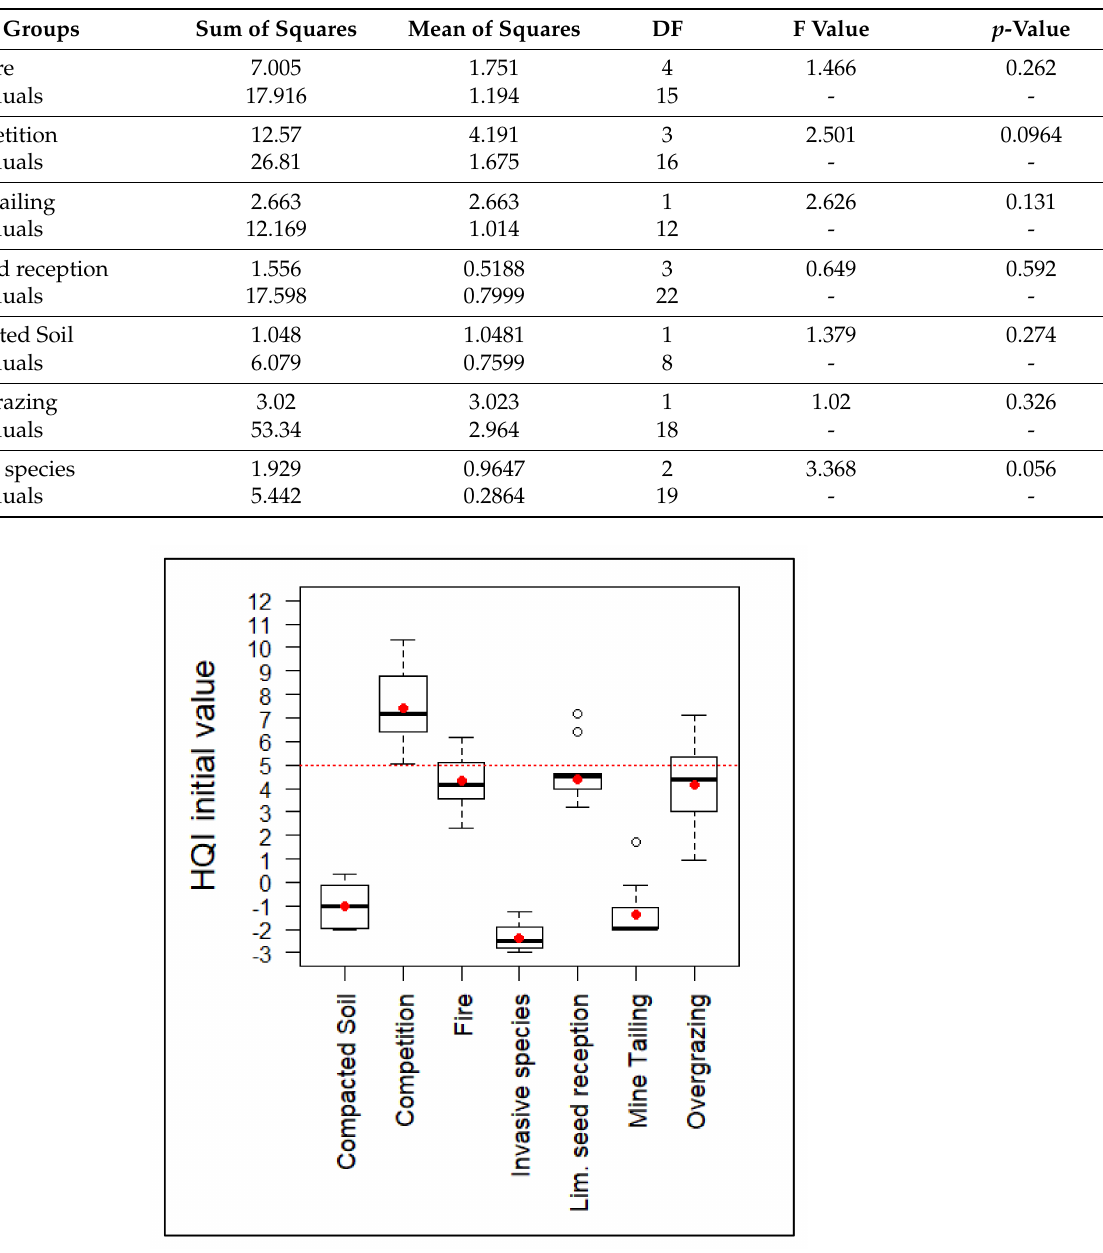
Figure 3. HQI values before the implementation of habitat improvement actions. Red dotted line represents the value from which the habitat quality index is considered favorable. Average value of the groups is represented by a red